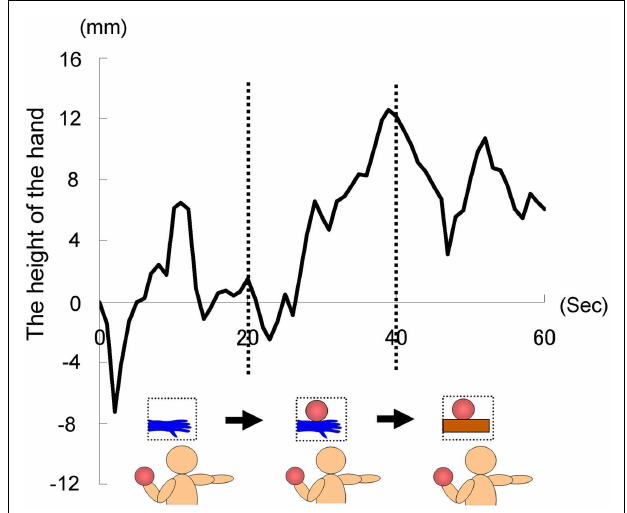
FIGURE 7 |Time course of the height of the hand in each condition in Experiment 2A.